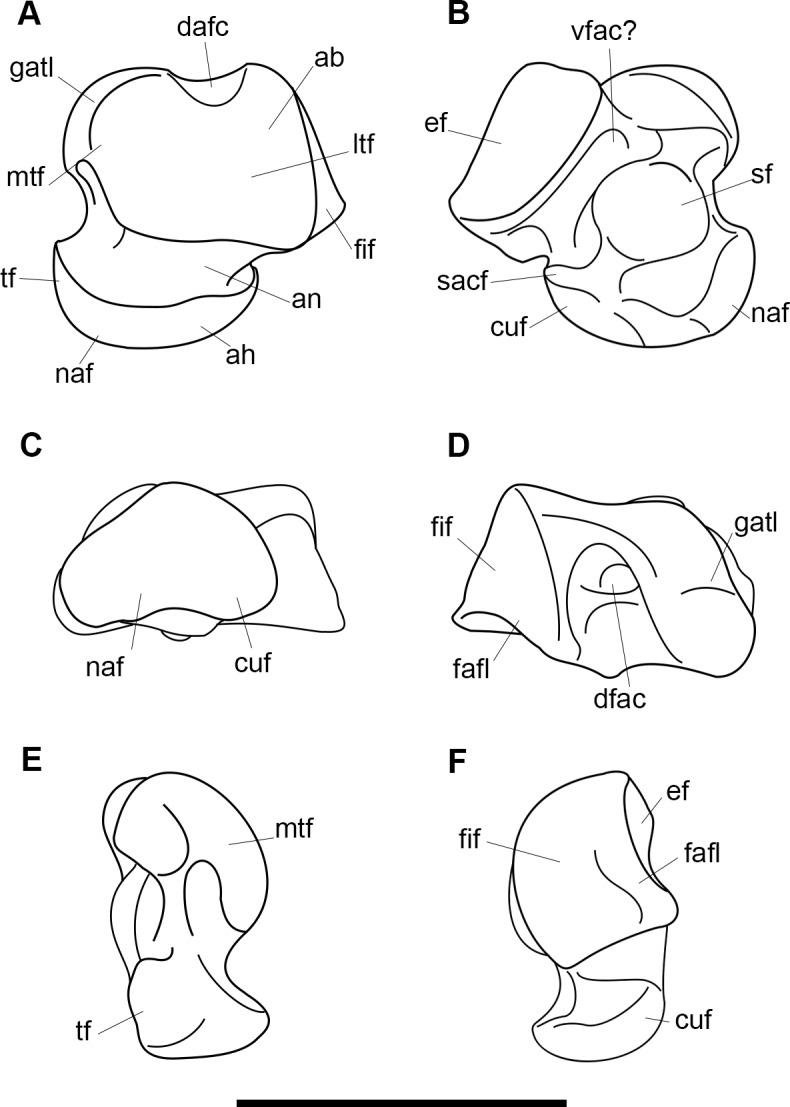
Annotated line drawing of the left astragalus of Periptychus carinidens.(A) dorsal view; (B) plantar view; (C) anterior view; (D) posterior view; (E) medial view, (F) lateral view. Abbreviations: ab, astragalar body; ah, astragalar head; an, astragalar neck; cuf, cuboid facet; dfac, dorsal foramen of the astragalar canal; ef, ectal facet; fafl, fossa for the astragalofibular ligament; fif, fibular facet; gatl, groove for the astragalotibial ligament; ltf, lateral tibial facet; mtf, medial tibial facet; naf, navicular facet; sacf, supplementary astragolocalcaneal facet; sf, sustentacular facet; tf, tibiale facet; vfac?, ventral foramen of the astragalar canal (opening not discernible). Scale bar: 30mm.